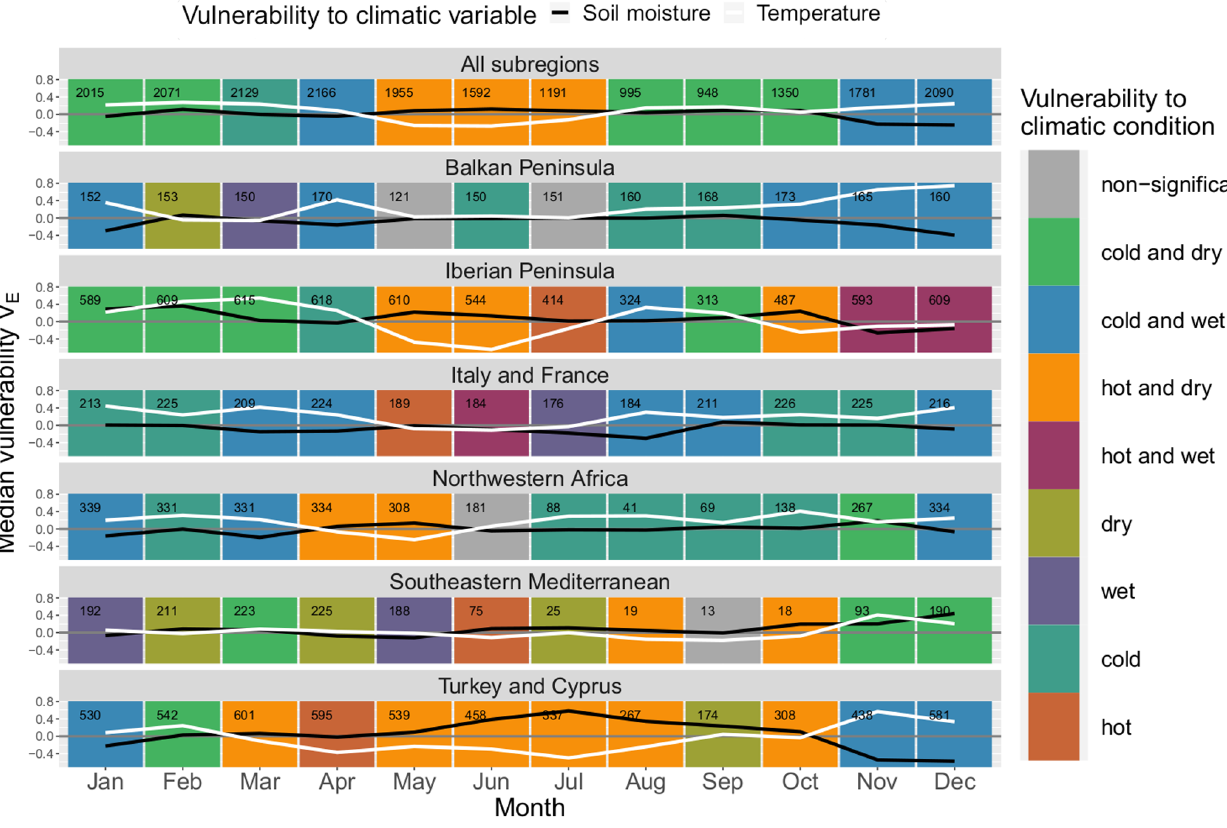
Figure A2. Median monthly ecosystem vulnerability per subregion. Vulnerability to temperature (ERA5-Land) is shown in white, and vulnerability to soil moisture (ERA5-Land at depth 0–7cm) is shown in black for each month of the year (columns) for each land cover (rows). Months with statistically significant deviation in climatic drivers during non-hazardous and hazardous ecosystem conditions according to the Mann–Whitney U test based on a significance level α = 0 . 05 are shown in colour (see legend); all other months are shown in grey. The number of grid points in which an event has occurred in this month and land cover within the period 1999–2019 is shown in the upper left corner of each